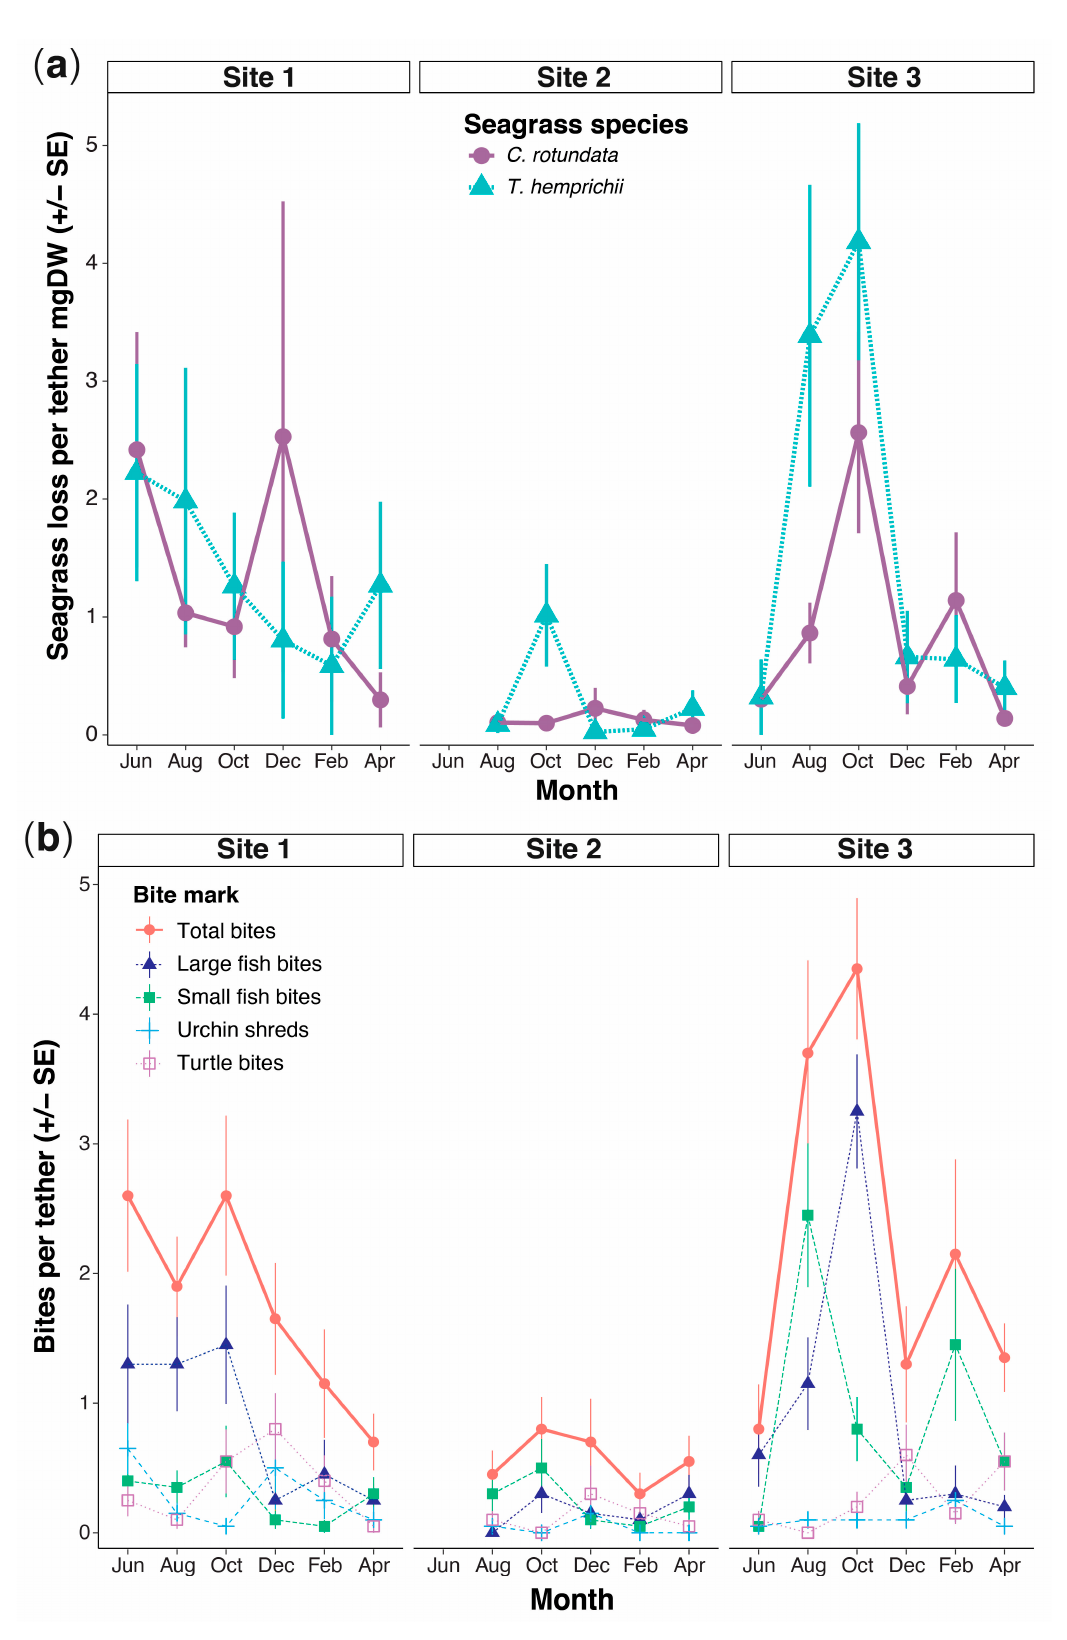
Figure 3. Seagrass loss (mgDW) per tether due to macroherbivory (turtle bites excluded) during the experiment ( a ) and bites per tether showing the overall total and types of bite marks present ( b